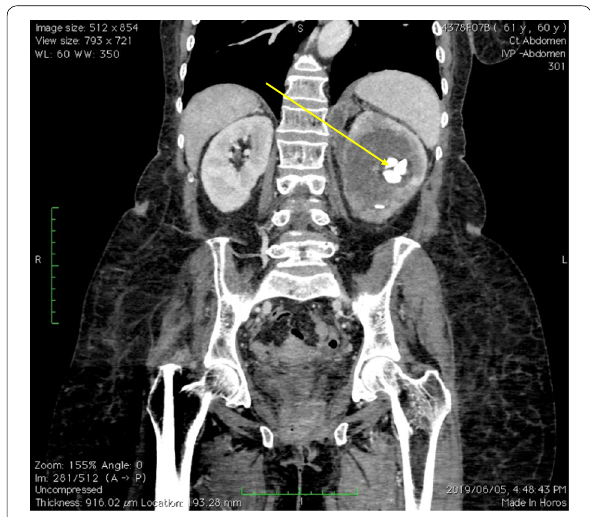
Fig. 2 Contrast-enhanced CT scan of the abdomen showing left-sided mid-pole calculi (arrow) with